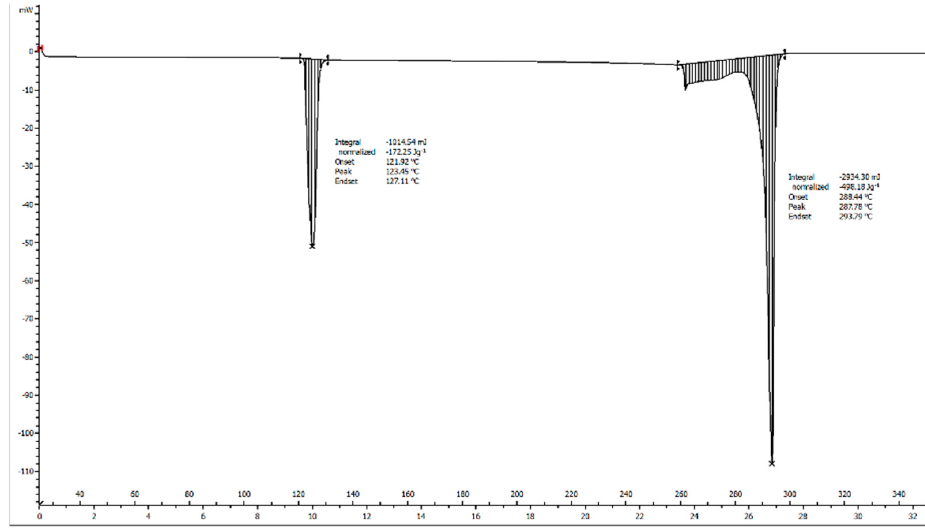
Figure A2. DSC thermogram of benzoic acid crystallized in neat water.